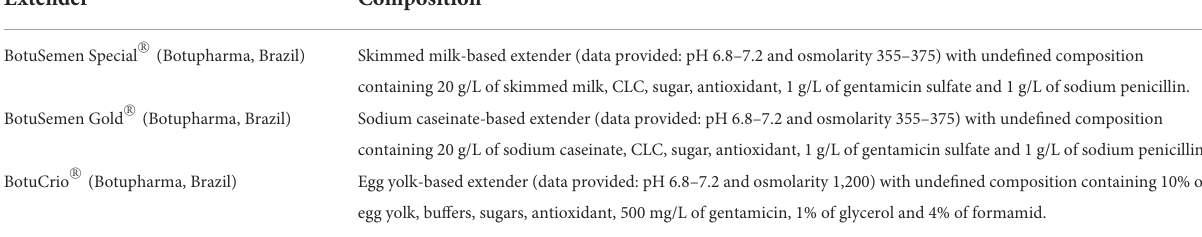
TABLE 1 Composition of the extender used for cooling donkey